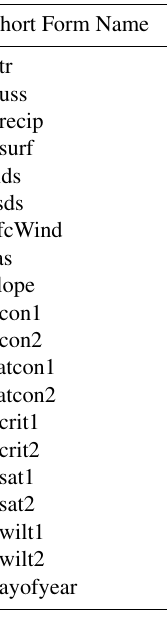
Table 2. A table showing the forcing data variables considered